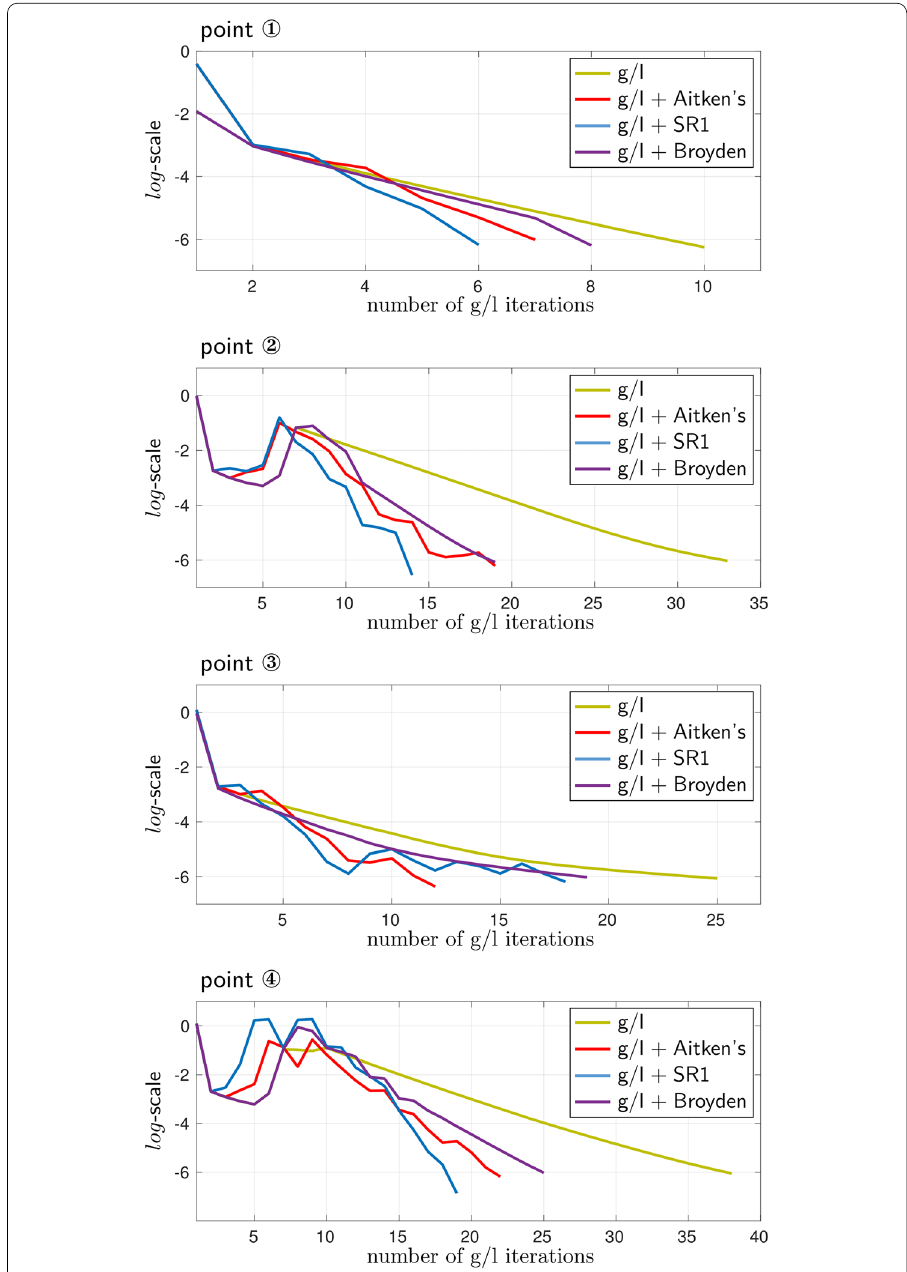
Fig. 13 Convergence behavior of the different versions of the global/local iterative solution process at four different loading steps (the points 1–4 from Fig. 5c), illustrated in terms of the indicator η